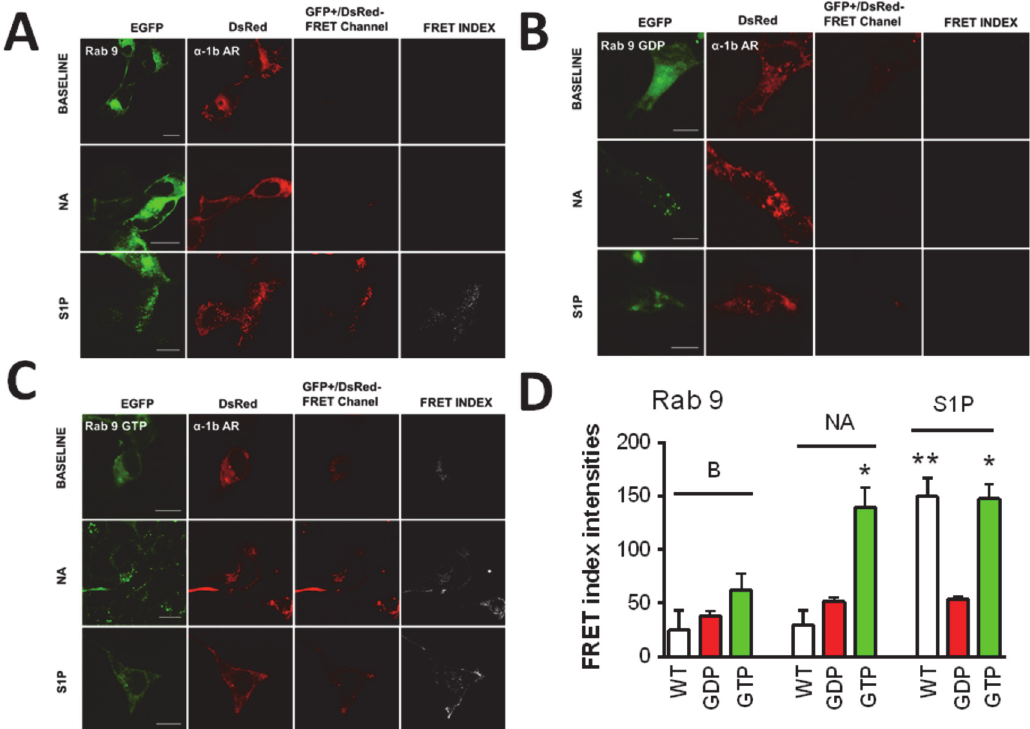
Fig 8. α 1B -Adrenergic receptor-Rab 9 interaction. Images of cells coexpressing α 1B -adrenergic receptors tagged with the DsRed fluorescent protein ( α 1B - AR) and Rab 9 tagged with the enhanced green fluorescent protein (EGFP). Other indications as in Fig. 1. Panel A, wild-type Rab 9 (WT); panel B, dominant- negative Rab 9 (Rab 9-GDP); and panel C, constitutively-active Rab 9 (Rab 9-GTP). In panel D, the quantitative analysis of the FRET index is presented. Plotted are the means and vertical lines representing the S.E.M of 5 – 10 experiments using different cell preparations. * p < 0.001 vs. Rab 9-GTP baseline (B); ** p < 0.001 vs. wild-type baseline (B) and wild-type stimulated with noradrenaline (NA). Scale bars: 15 μ m.